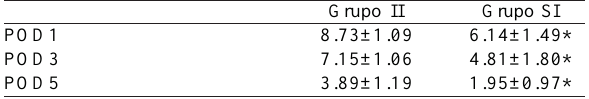
Table 4. Values of subjective chest pain sensation on 1, 3 and 5 PODs.